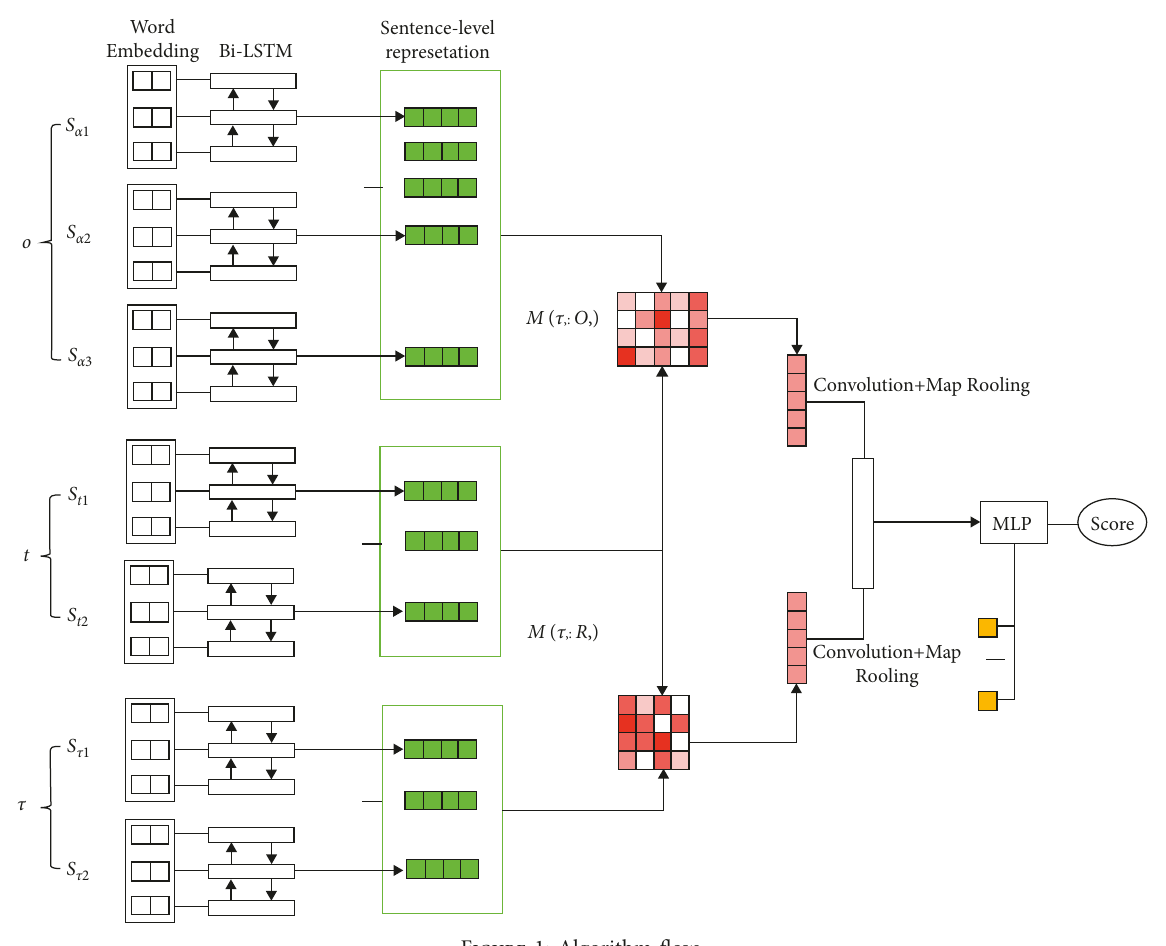
Figure 1: Algorithm